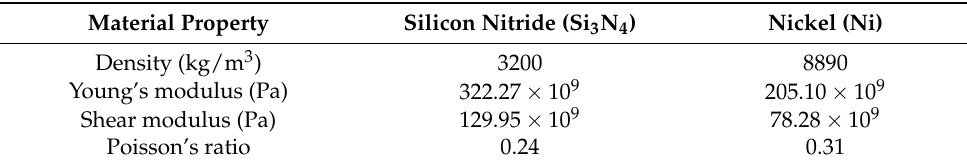
Table 2. Material properties of the FG micro-switch.